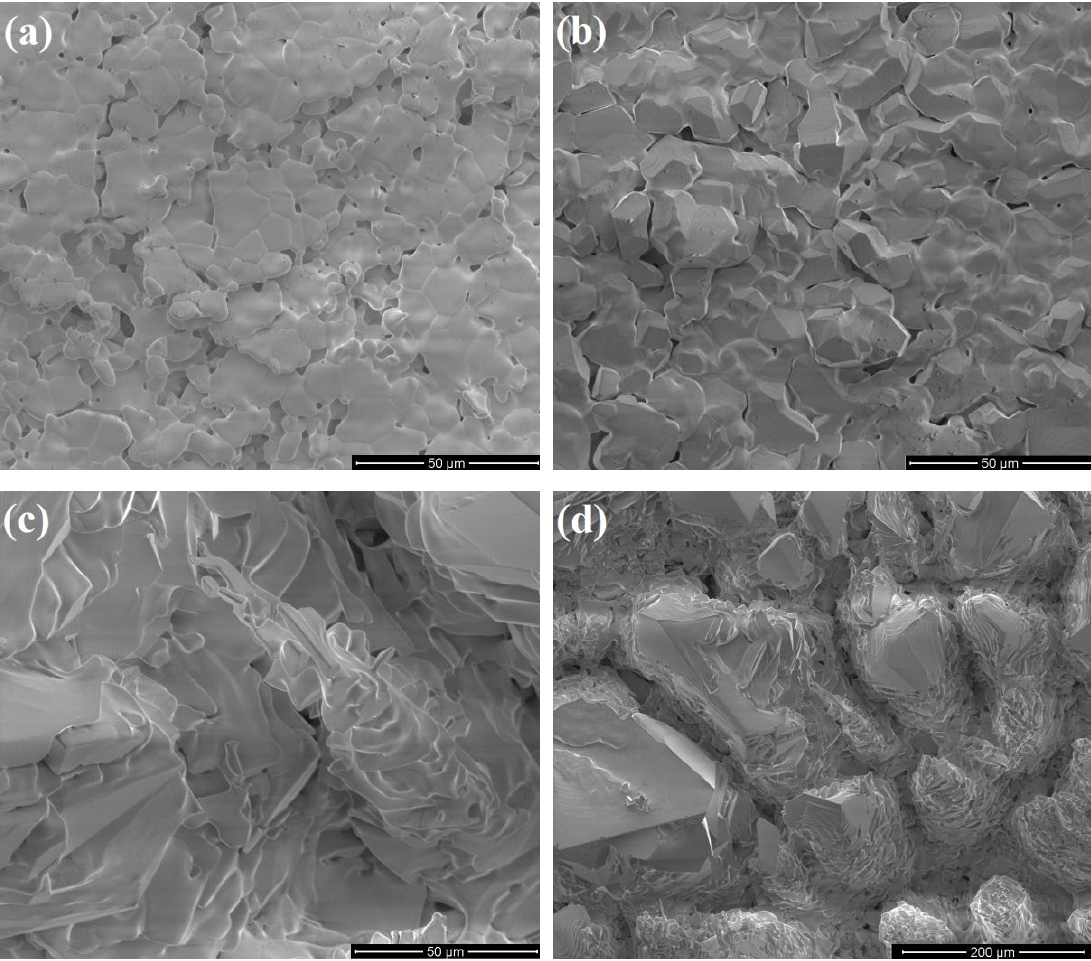
Figure 10. SEM images of the porous ceria pellet after 10 cycles: ( a ) near the edge; ( b ) between the edge and the center; ( c ) near the center; ( d ) near the center with low magnification. All images are at 1000 × magnification except ( d ), which is at 250 × magnification.